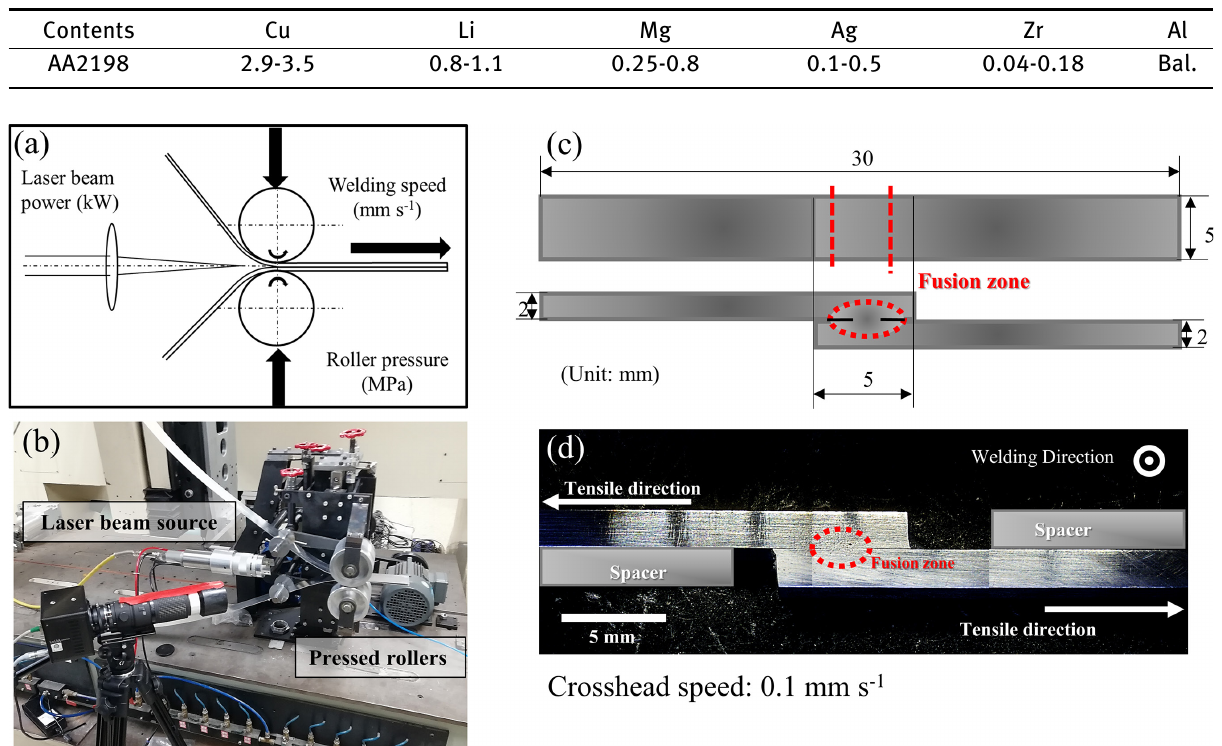
Table 1: Chemical composition of AA2198-T8 [wt.%]